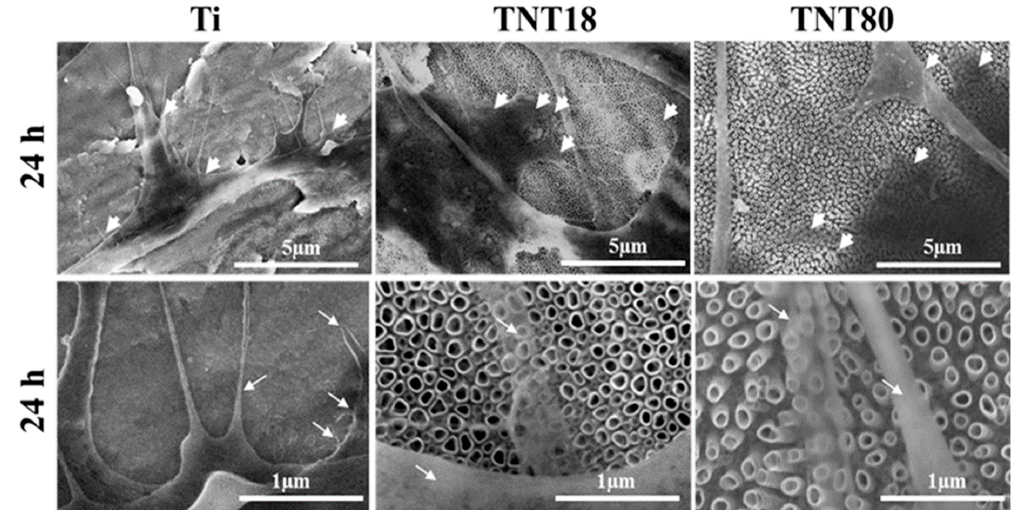
Figure 4. SEM images of the MC3T3-E1 pre-osteoblasts maintained in contact with Ti, TNT18 and TNT80 surfaces for 24 h. The white arrowheads show the location of cellular extensions; filopodia are indicated with white